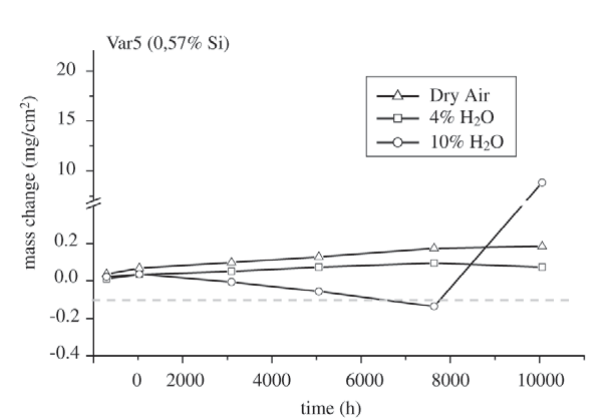
Figure 8. Results of mass change measurement as a function of time for Variation 3 of Nf616 at 650 °C in different environments.